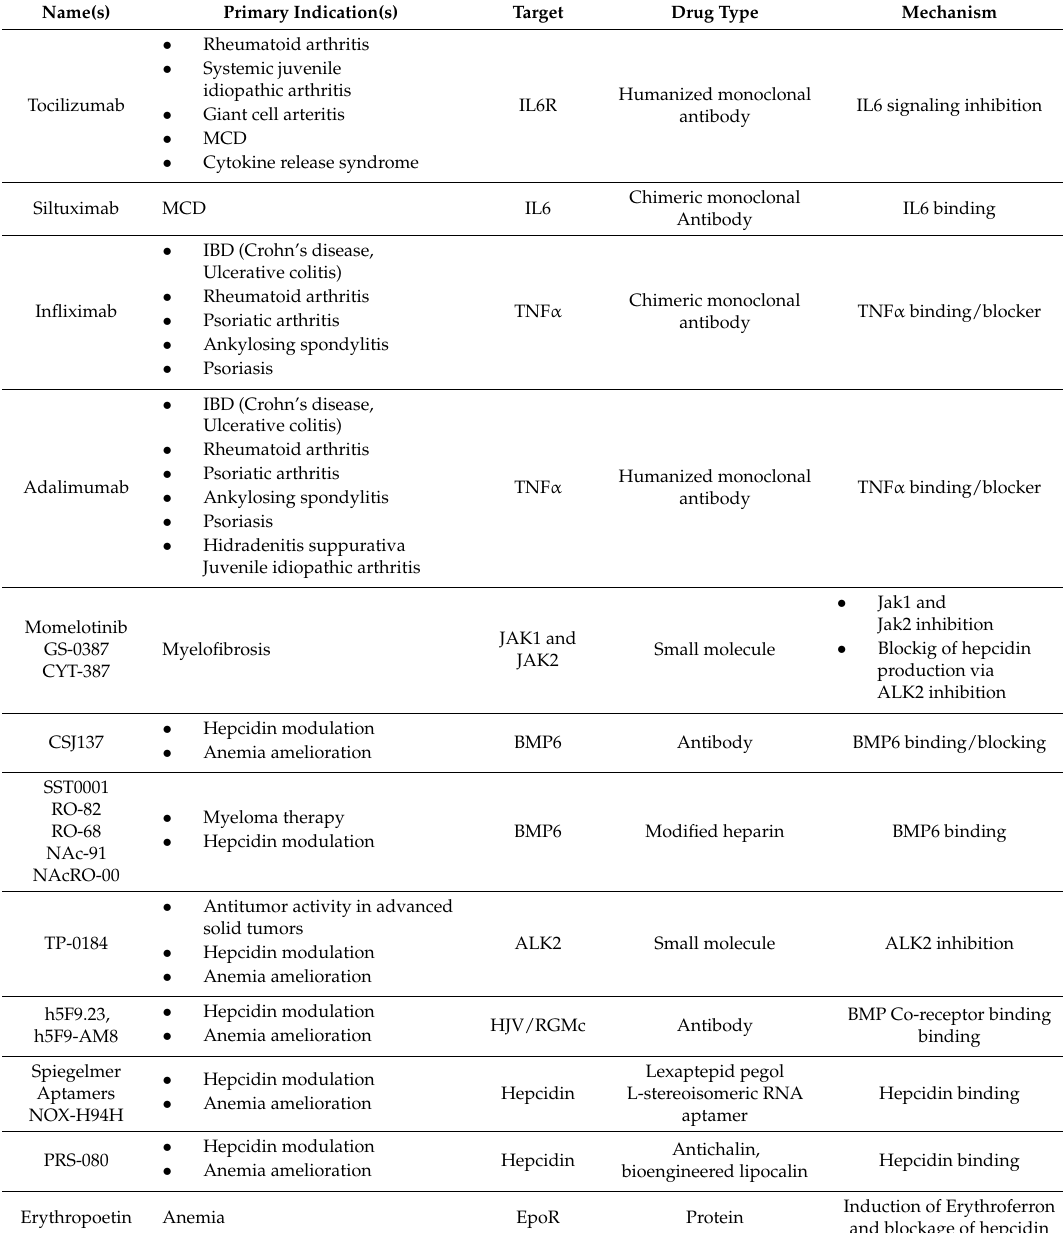
Table 3. Drugs impacting on hepcidin-mediated alteration of iron